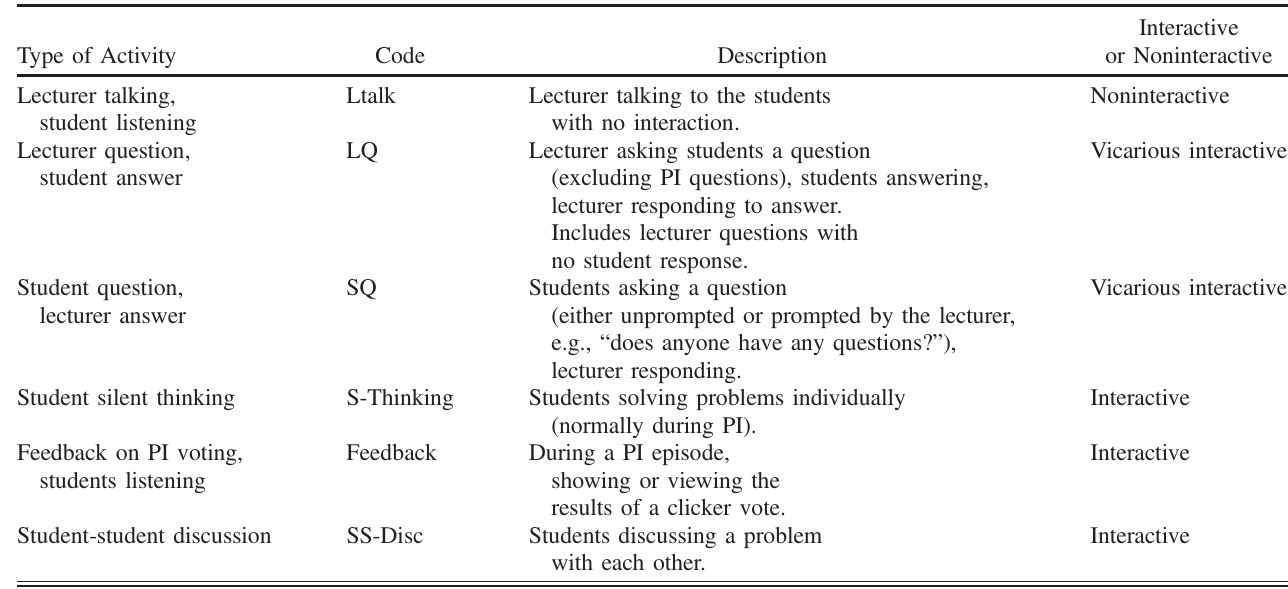
TABLE I. Codes for lecture activity. Note interactive and vicarious interactive are defined as activities in which students interact with the lecturer, with each other, and with the material. See Sec. II B for more